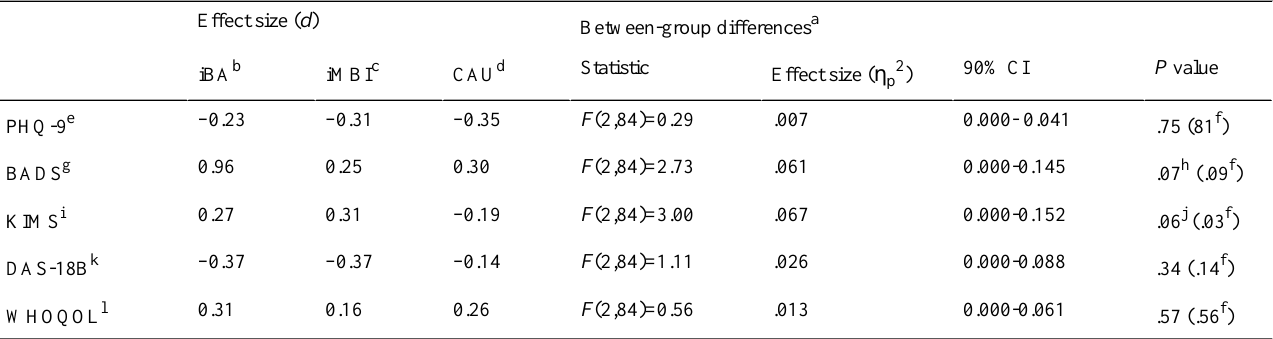
Table 3. Outcome analyses, including the effect sizes for and between-group differences in the outcome measures between the baseline (t 0 ) and 2-week post-treatment (t 1 ) assessments in the complete-cases group.